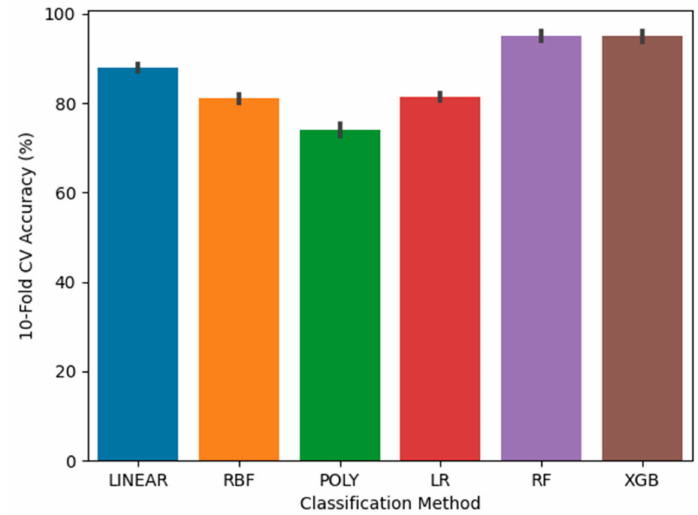
Figure 4. 10-fold CV accuracy for default classification methods (Case 1).